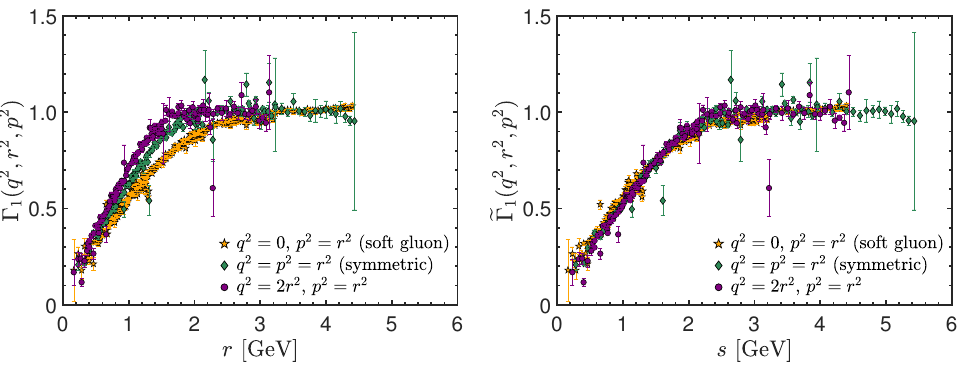
Γ 2 , r 2 , p 2 ) , of the trans- 1 ( q (cid:101) Γ 2 , r 2 , p 2 ) is plotted as a function of r , while in the right 1 ( q (cid:101)